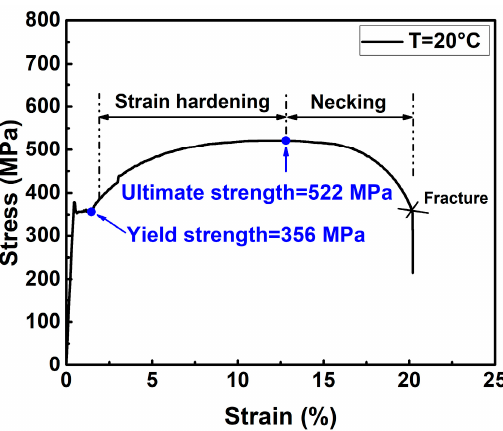
Figure 4. The measured stress-strain curve of the base metal.